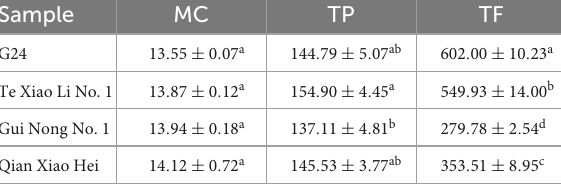
TABLE 1 Total phenolics (mg GAE/100 g DW), total flavonoids (mg RE/100 g DW), and moisture contents (%) of adzuki beans. Sample